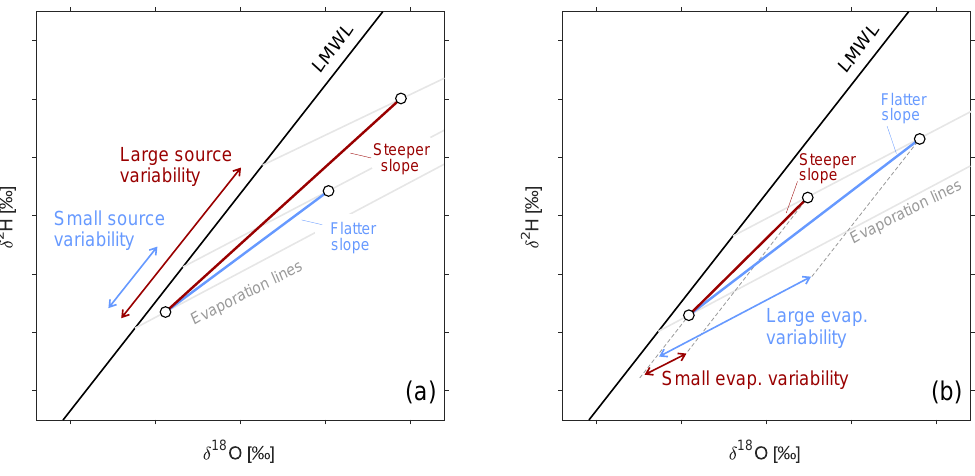
Figure 8. Effects of precipitation source variability (a) and evaporation variability (b) on the trend line that interpolates evaporated soil water samples (dots). The trend line is much steeper than the evaporation lines, unless there is no variability in the source water isotopic